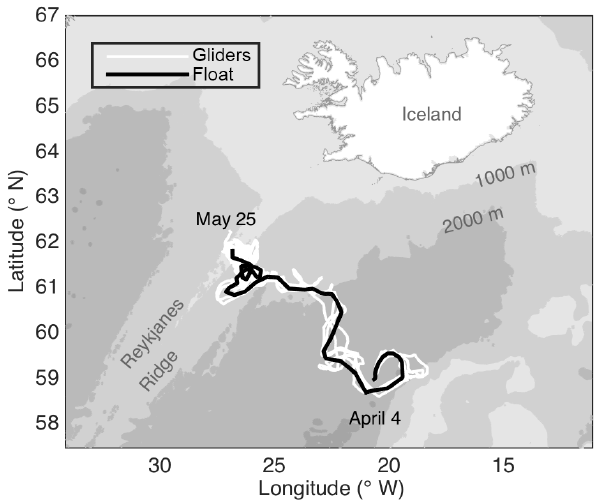
Figure 1. Study area with tracks of an autonomous Lagrangian mixed-layer float and autonomous